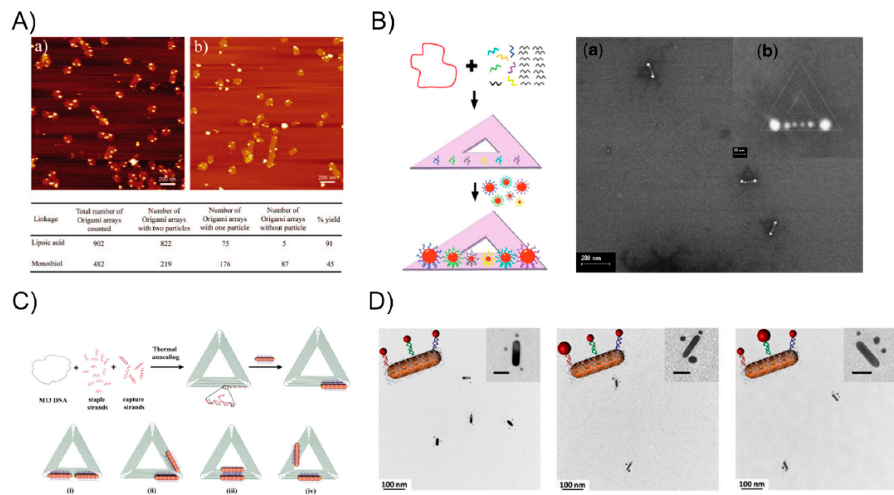
Figure 2. The DNA origami-guided AuNP nanoarchitectures. ( A ) The Dithiol-modified origami tile for assembling the AuNP dimer with a high yield. ( B ) The bowtie-like self-similar chain alignment on triangular DNA origami. ( C ) Anisotropic plasmonic nanostructures using triangular DNA origami. ( D ) Well-defined heterostructures by using DNA origami clamps. Reproduced with permission from